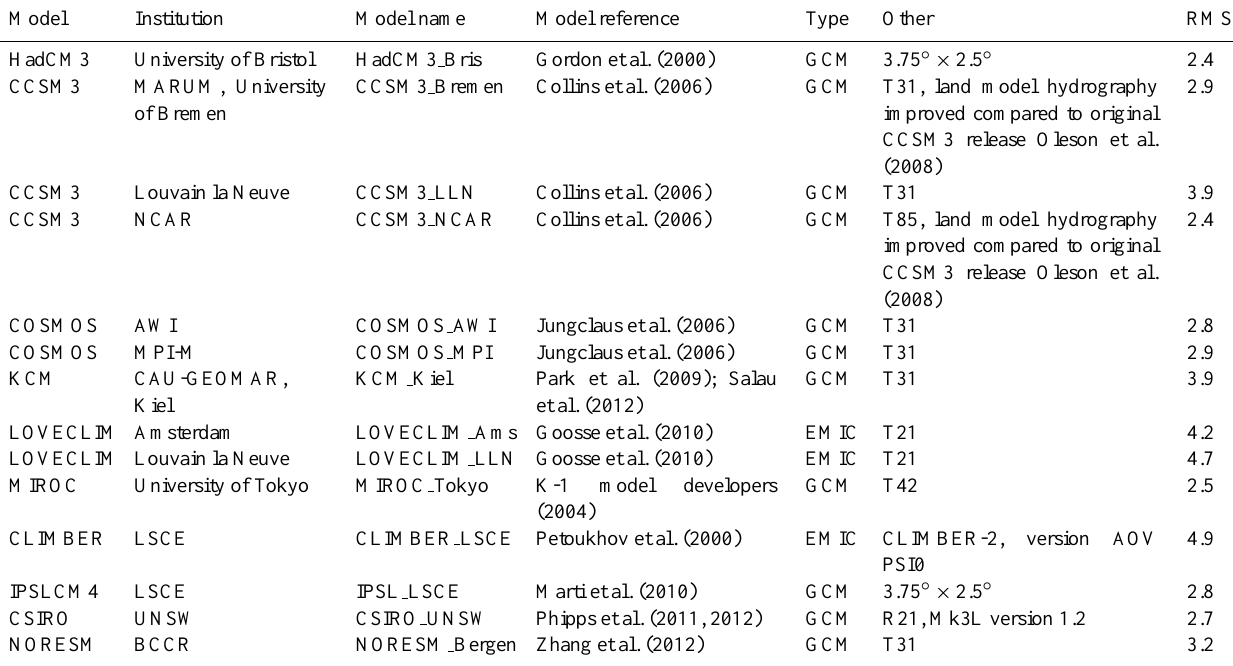
Table 1. Summary of models in this intercomparison. “Type” refers to the atmospheric component of the model: GCM (General Circulation Model) or EMIC (Earth system Model of Intermediate Complexity). “RMS” gives the RMS “error” of the pre-industrial simulation surface air temperature ( ◦ C) relative to the NCEP climatology (see Fig. 4). Note that the RMS error is not area